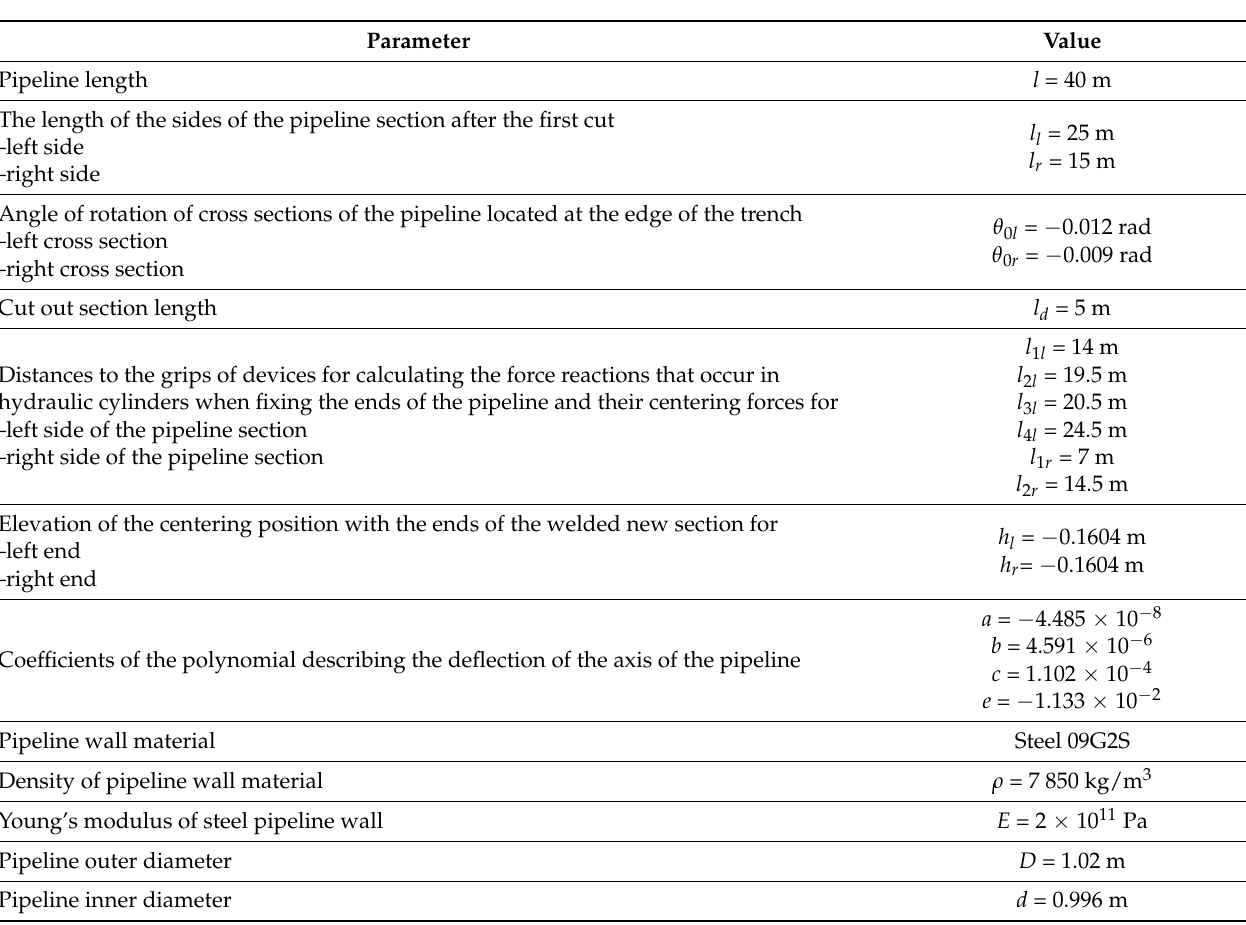
Table 3. Initial data for calculation.